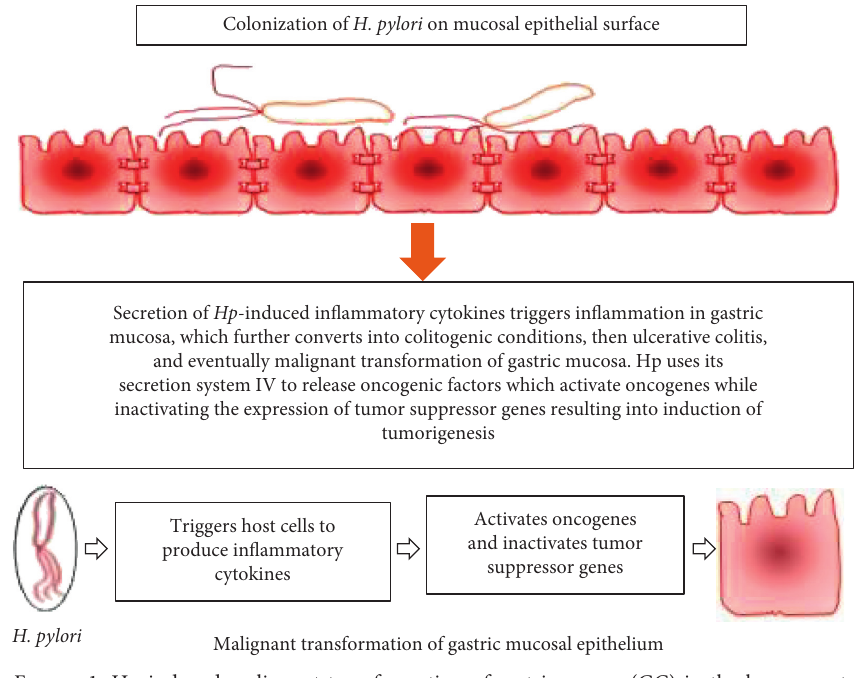
Figure 1: Hp-induced malignant transformation of gastric cancer (GC) in the human